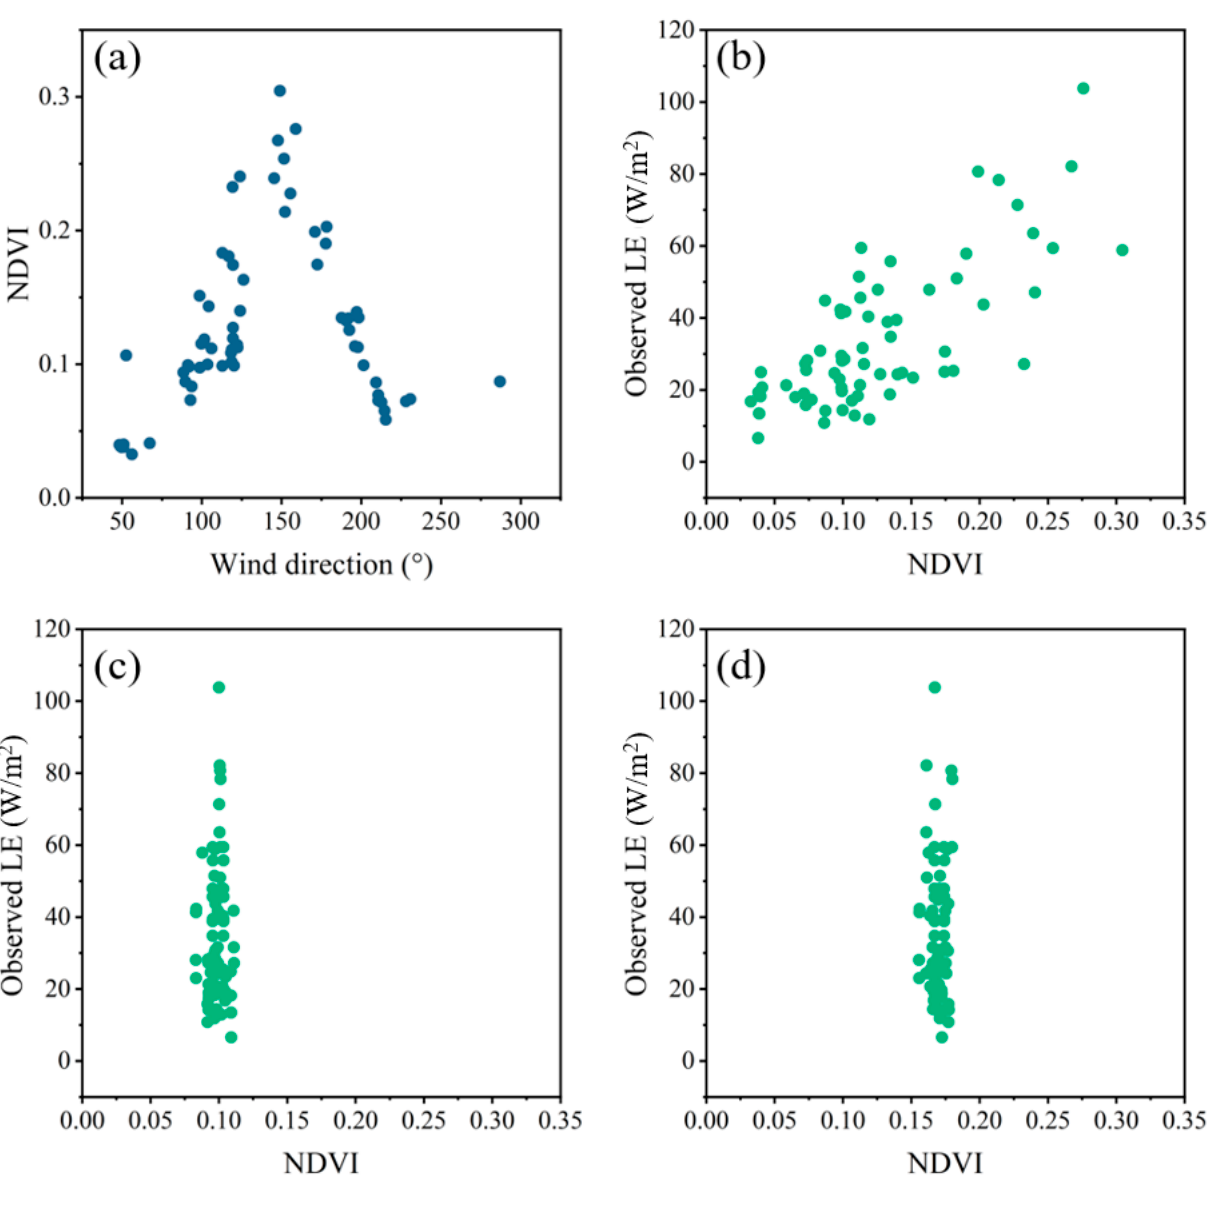
Figure 12. Scatter plots of ( a ) dynamic footprint-weighted NDVI versus wind direction; observed LE versus weighted NDVI within ( b ) dynamic footprints, ( c ) the historical footprint, and ( d ) the fixed circle area.